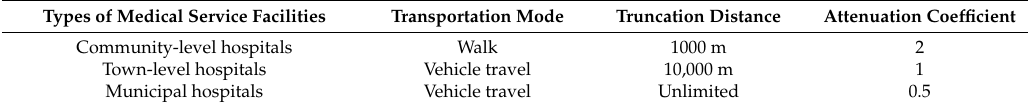
Table 1. Table for distance decay indicators for different hospital